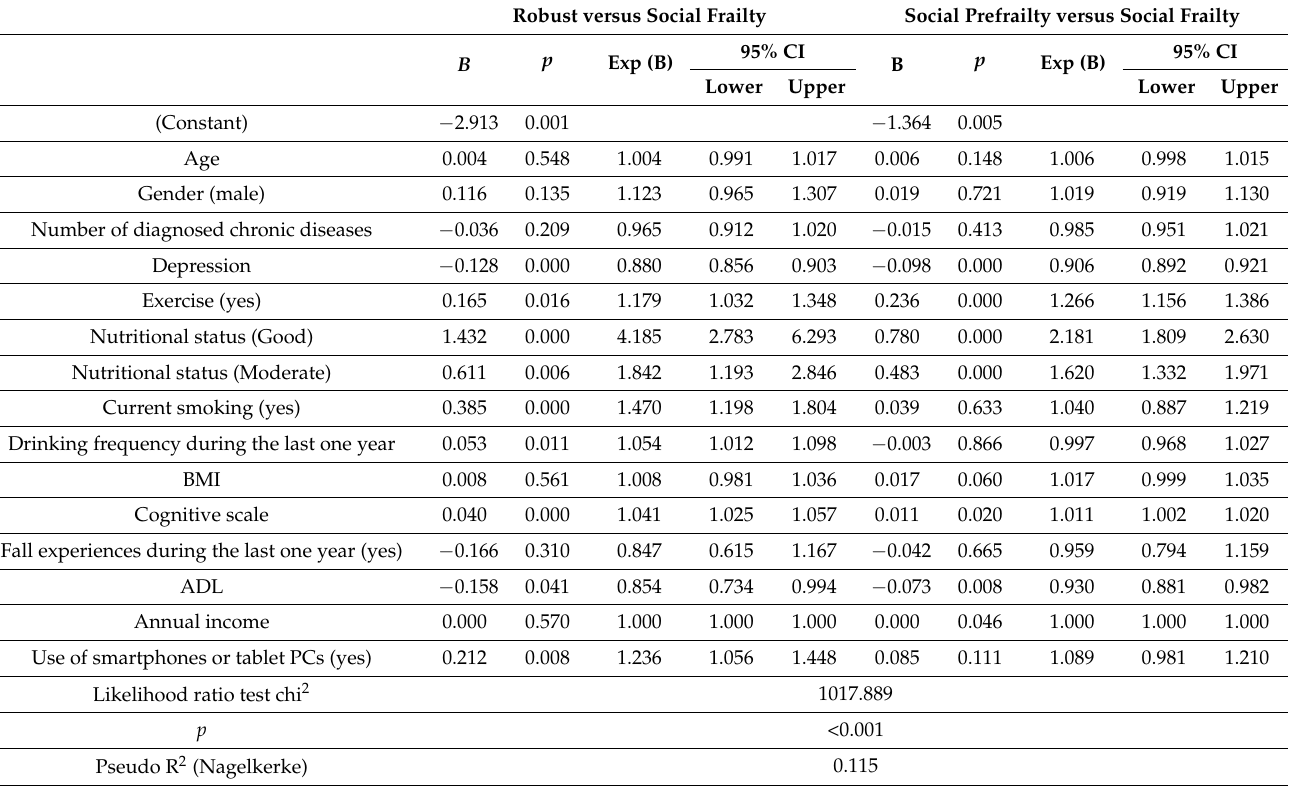
Table 3. Results of multinomial logistic regression. Robust versus Social